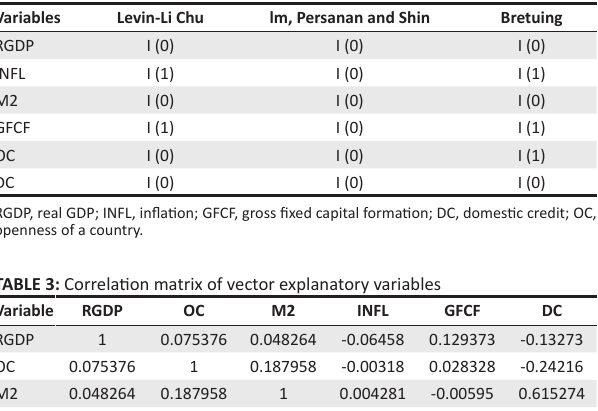
TABLE 2: Unit root tests. Variables